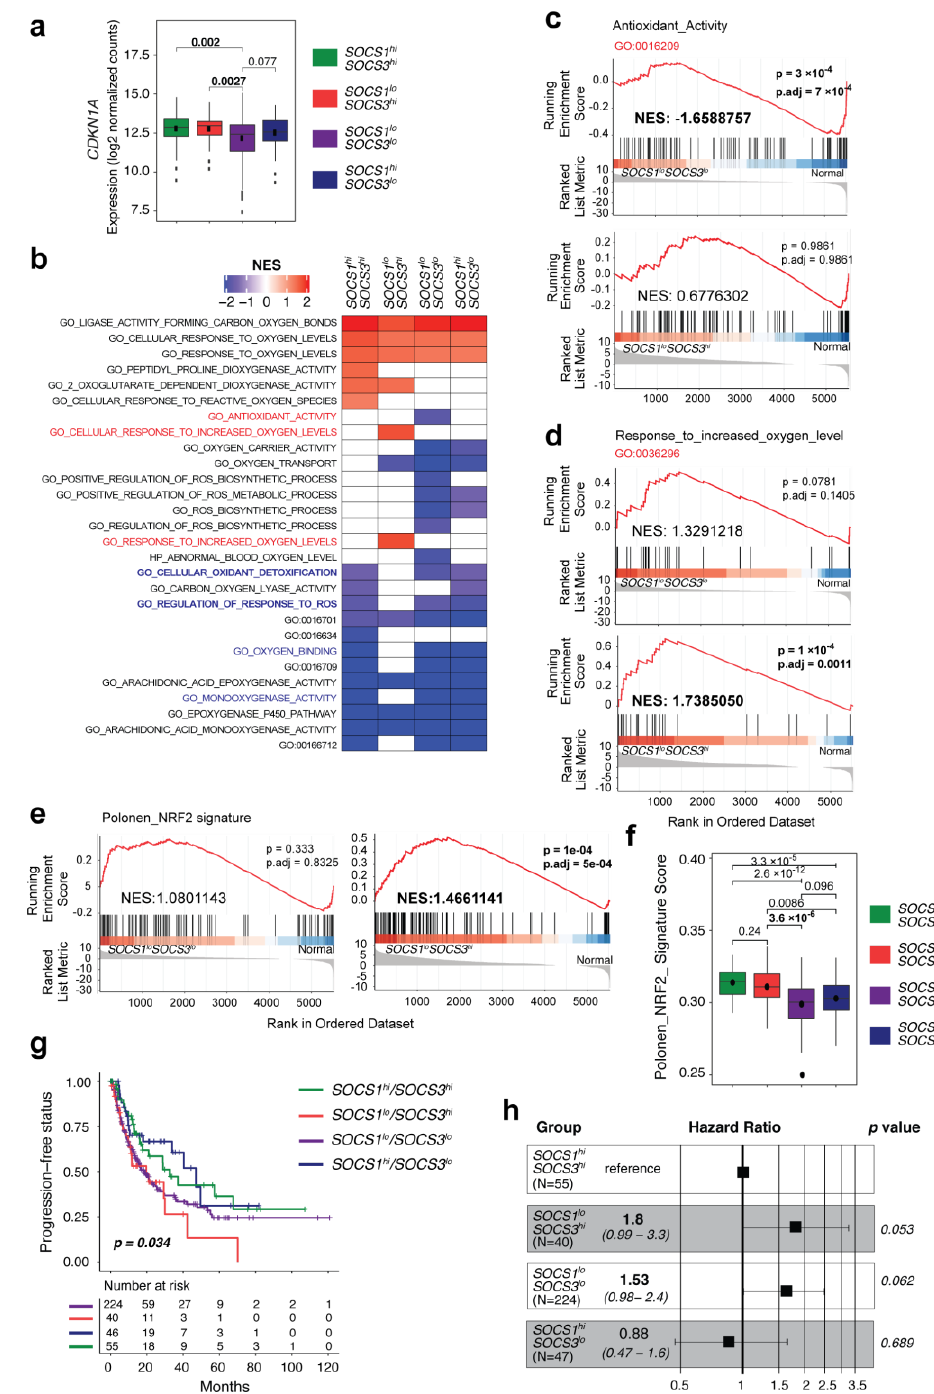
Figure 4. High SOCS3 expression in SOCS1-low human HCC cases is associated with elevated CDKN1A expression, enrichment of NRF2 signature genes, and fast disease progression. ( a ) Increased CDKN1A expression in SOCS1-low/SOCS3-high HCC than in SOCS1-low/SOCS3-low group. ( b ) Gene set enrichment analysis (GSEA) for biological pathways containing the term ‘oxygen’ and ‘oxidant’ in the indicated HCC groups compared to normal liver tissues. GO terms that are indicated only by numbers are given names in Supplementary Figure S4c. ( c – e ) GSEA plots showing negative enrichment of Antioxidant_Activity’ pathway genes in SOCS1-low/SOCS3-low group ( c ) and positive enrichment of ‘Response_to_increased_oxygen_level’ pathway ( d ) and ‘Polonen_NRF2 Signature’ genes ( e ) in the SOCS1-low/SOCS3-high group. ( f ) Comparison of the enrichment of Polonen_NRF2 Signature genes in the indicated HCC subgroups. ( g ) Kaplan-Meier survival plot of the TCGA-LIHC cohort grouped based on SOCS1 and SOCS3 expression levels. ( h )